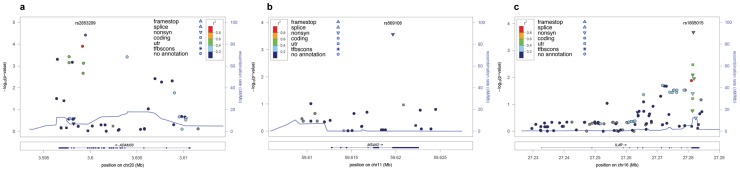

P-values of association by chromosome position with A) asthma ≤14years for ADAM33, B) asthma ≤39 years for MS4A2 and, C) asthma ≤39 years for IL4R.
P-values are expressed in –log10 scale. The SNP number shown on the plot denotes the result for the most significant SNP for each gene and the results for the remaining were color coded to reflect their LD with this SNP based on pairwise r
2 values from the 1KGP. Estimated recombination rates (from 1KGP) were also plotted on the right axis to reflect the local LD structure.